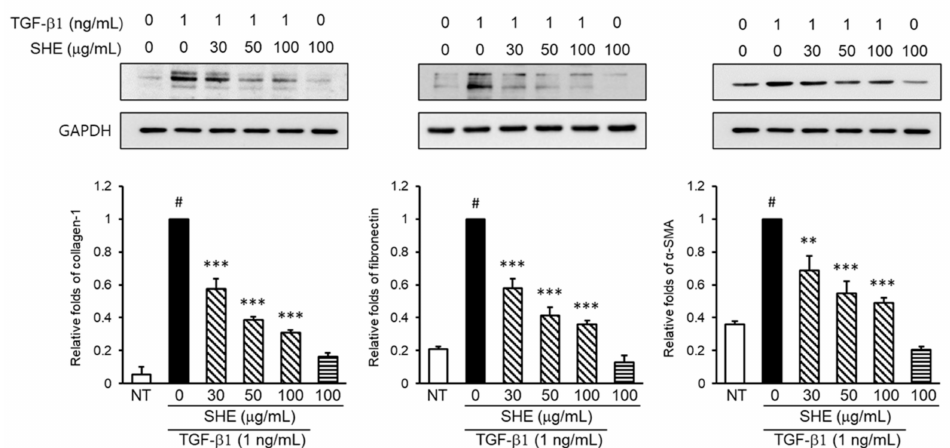
Figure 2. Effect of SHE on collagen-1, fibronectin, and α -smooth muscle actin ( α -SMA) protein expression by TGF- β 1-stimulated NPDFs. The cells were seeded at 6 × 10 4 cells/mL and incubated with various concentrations (30, 50, and 100 µ g/mL) of SHE for 1 h prior to TGF- β 1 stimulation (1 ng/mL). Following stimulation with TGF- β 1 for 24 h, collagen-1, fibronectin, and α -SMA protein expressions were determined by western blotting. GAPDH was used as an internal control. Each value indicates the mean ± SEM ( n = 3) and is representative of results obtained from three indepen- dent experiments. # p < 0.05 vs. control group (no treatment, NT); ** p < 0.01 and *** p < 0.001 vs. TGF- β 1-stimulated